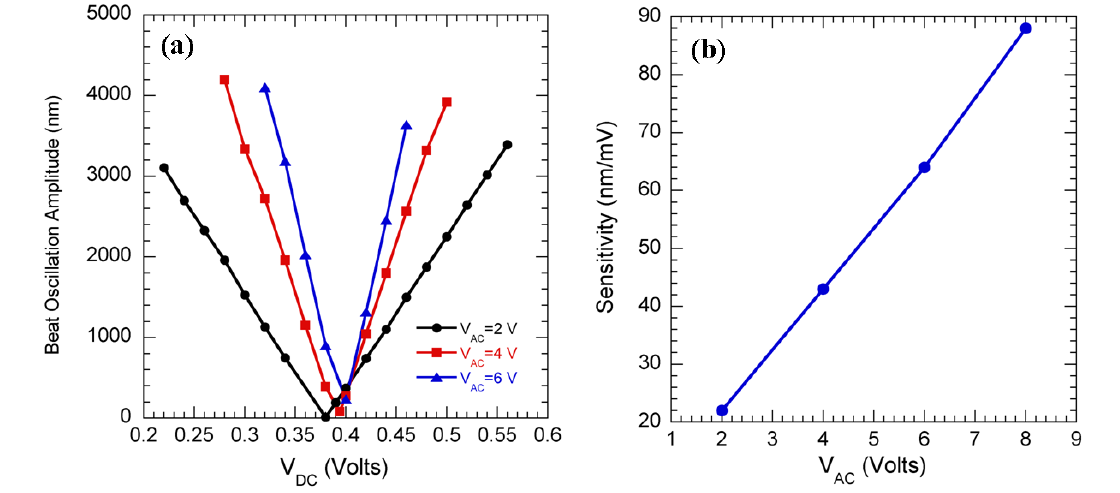
Figure 2. (a) Change in beat oscillation amplitude of the cantilever as a function of dc bias for 3 different ac biases, measured at a topography feedback gain of 0.6. (b) Sensitivity plotted as a function of ac